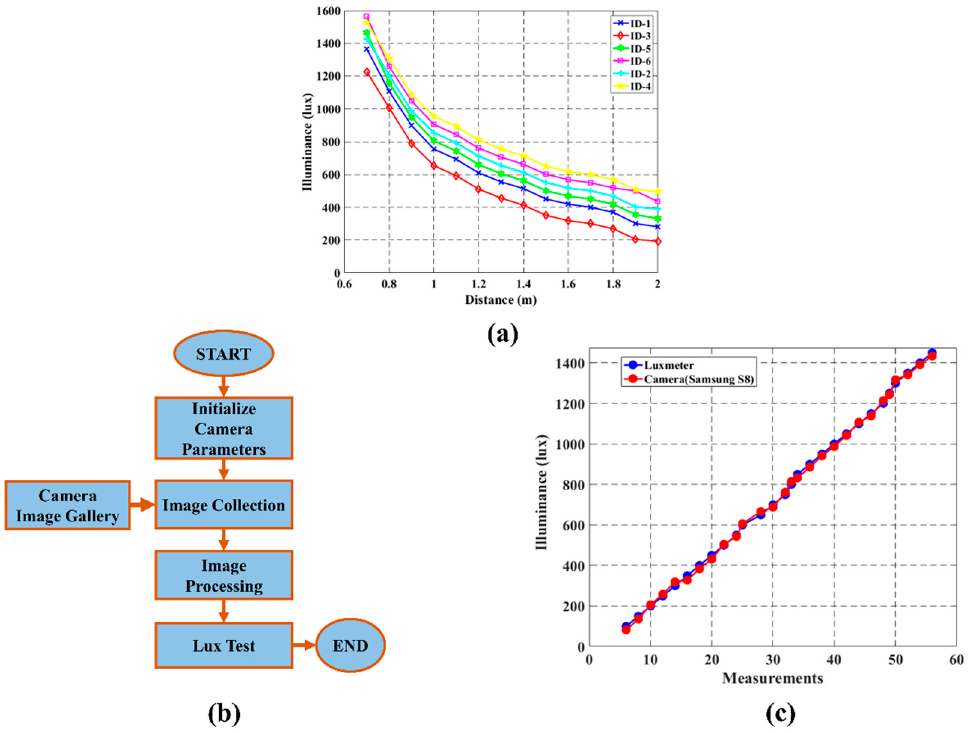
Figure 10. ( a ) Light intensity vs. communication distance; ( b ) flow chart of Android application for luminance measurement; ( c ) luxmeter vs. image sensor performance.